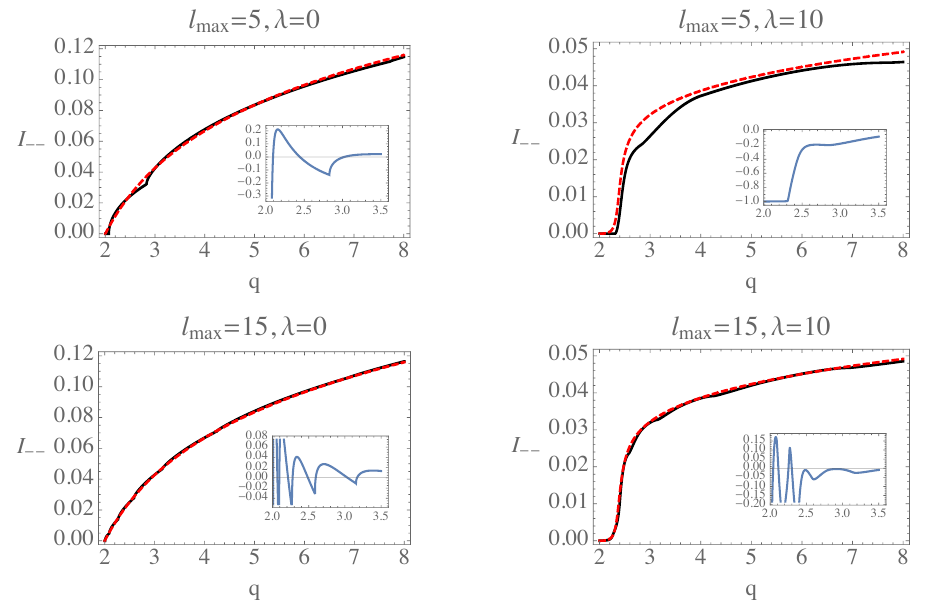
Figure 1 . Comparison with exact analytic result (red, dashed) and truncation result (black, solid) for various values of the coupling (cid:21) and truncation level ‘ max . The residuals (de(cid:12)ned as truncation are shown in the insets.